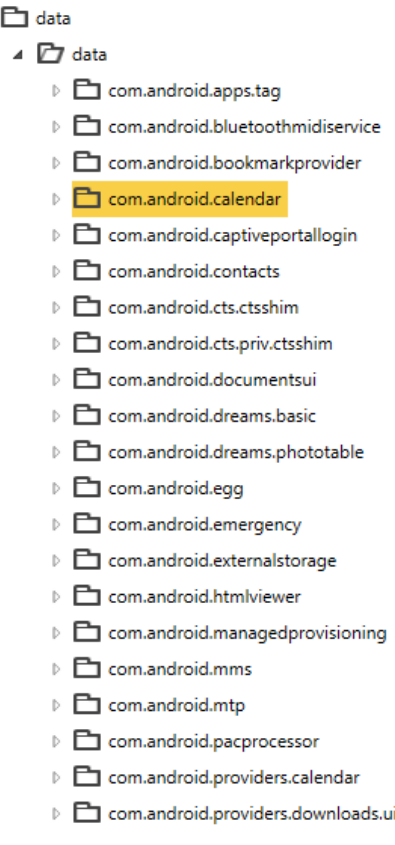
Figure 8. The full contents of the /data directory displayed in XRY shows that no Fitbit app or user data was